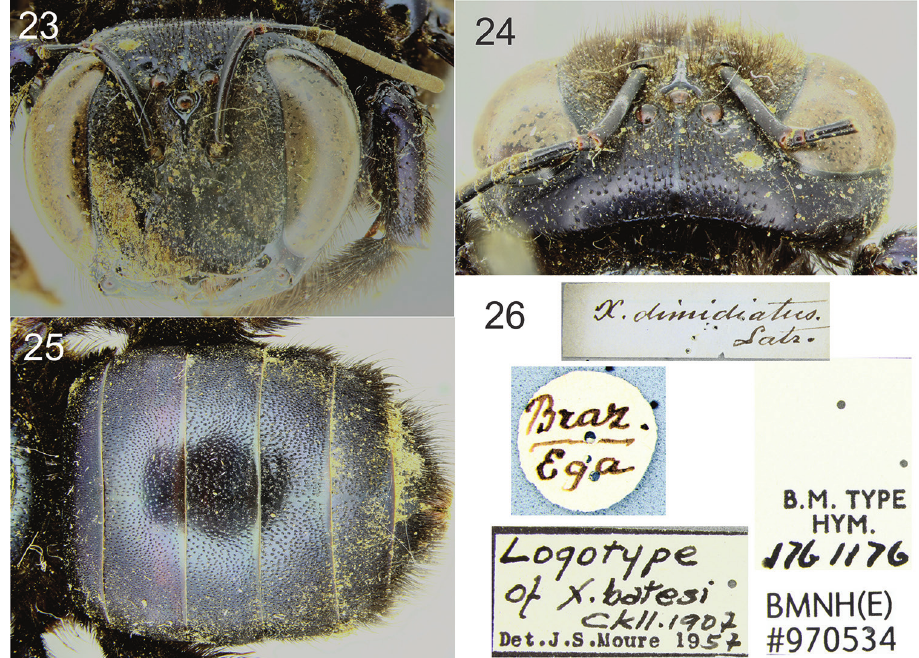
Figures 23–26. Specimen of the NHML identified as X. dimidiata Latreille by F. Smith. 23 Facial view 24 Dorsal view of head 25 Detail of terga 26 Associated locality and determination labels (Photographs by David Notton,